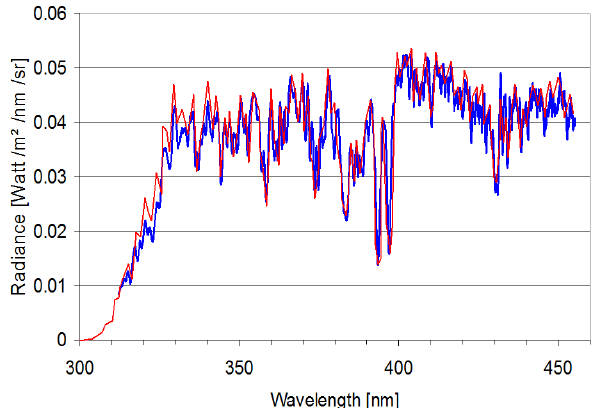
Figure 9. Comparison of a calibrated spectrum (blue), measured on 24 June 2009 at 06:54, at a SZA of 61 ◦ , and an independent mea- surement under similar conditions (red) on 2 May 2007 in Hanover, Germany (clear sky; SZA: 62 ◦ ; Seckmeyer et al., 2009). The mea- surement in Hanover was scaled by a factor of 0.97 to account for the effect of the slightly different viewing geometries (exact zenith view, compared to 85 ◦ elevation angle of our